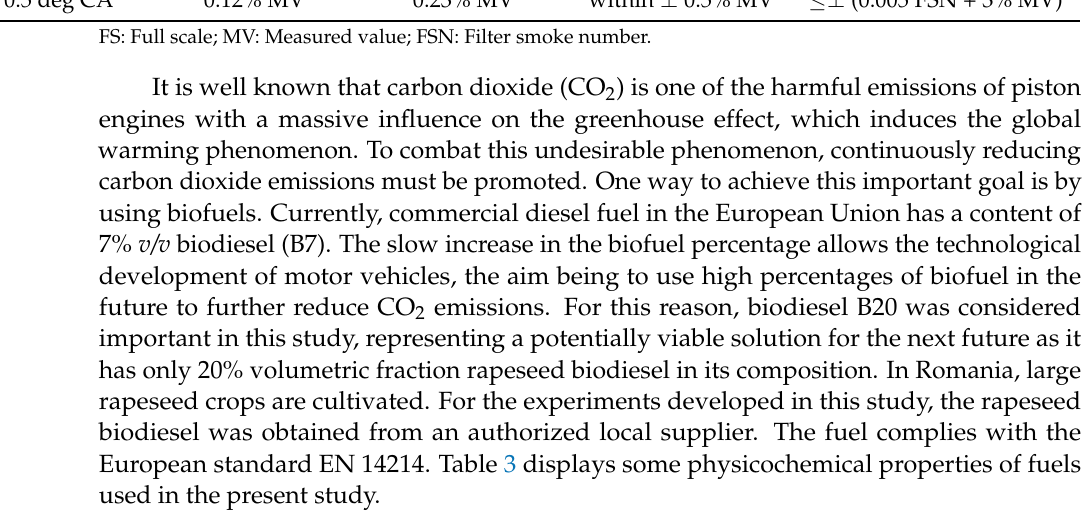
Table 3. Physio-chemical properties of diesel fuel D100 and biofuels B100 and B20